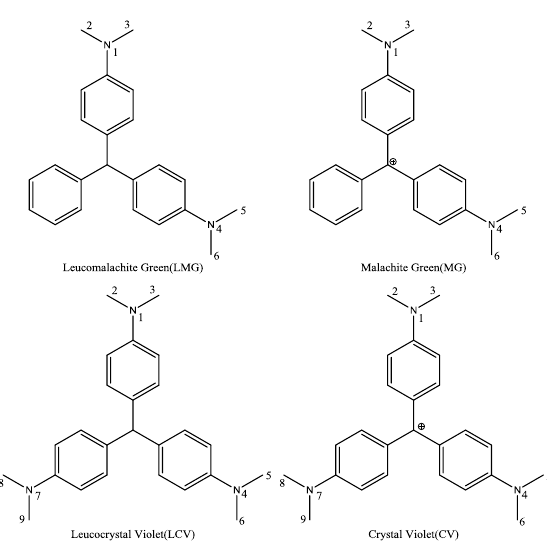
Figure 1. Structures of some representative triphenylmethane dyes.